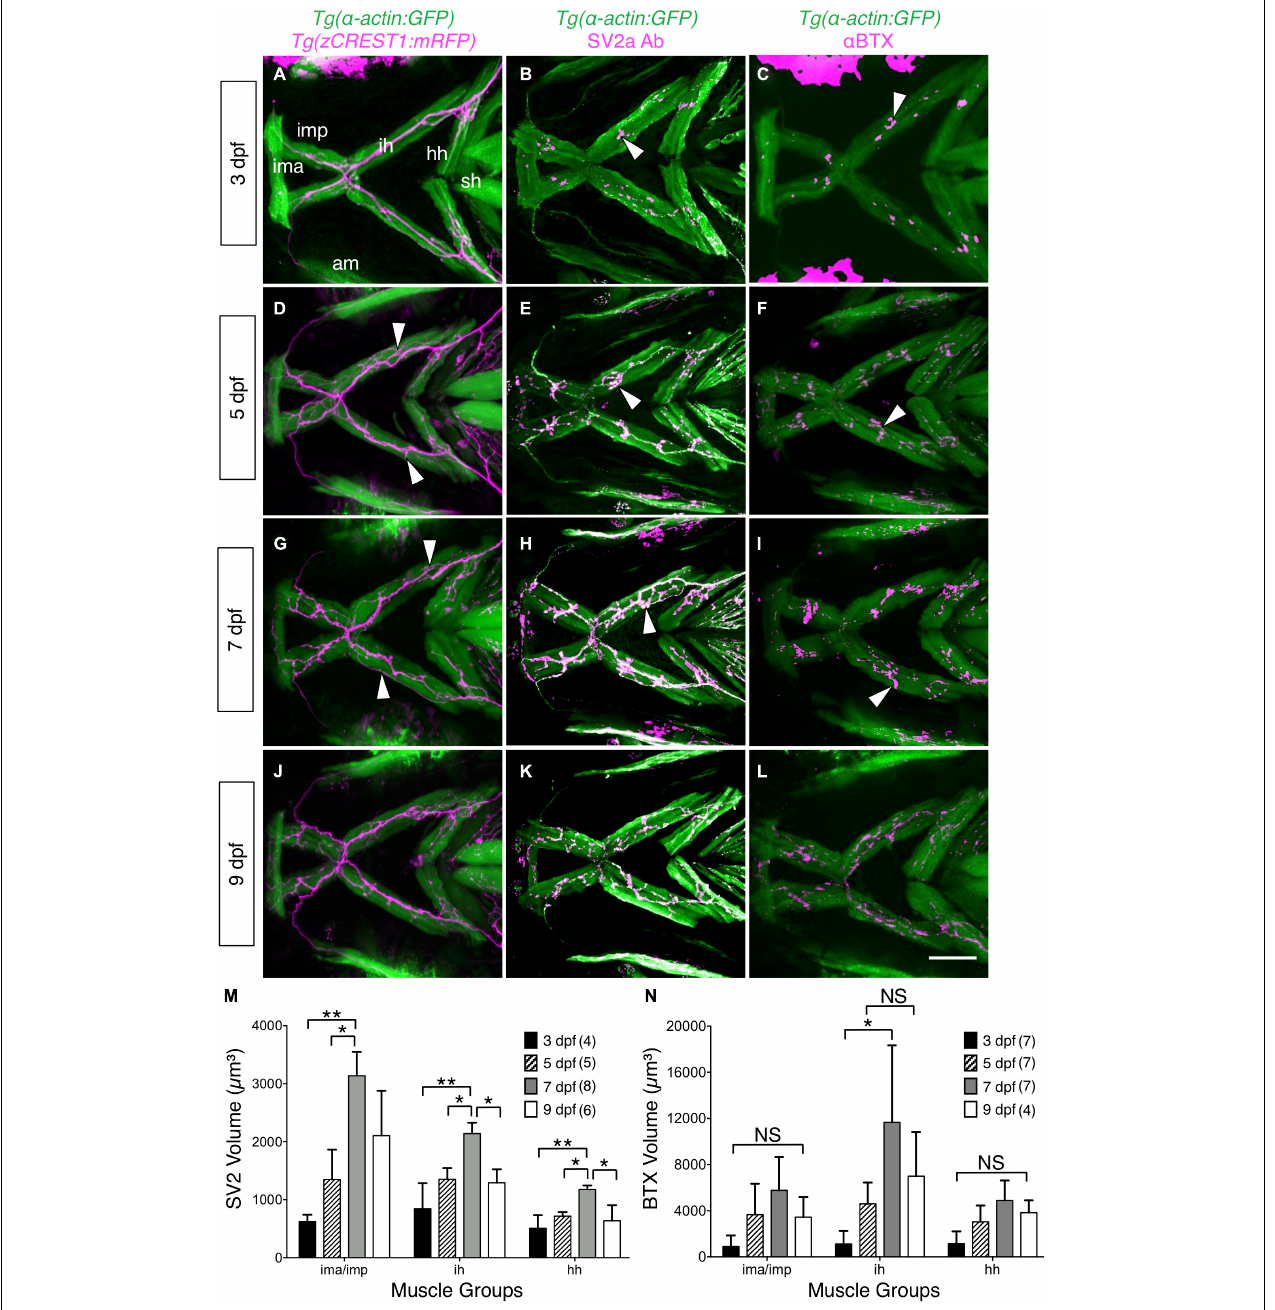
FIGURE 2 | Developmental changes in branchiomotor axon branching and synaptic structures at the jaw neuromuscular junctions. Ventral views with anterior to the left of the jaw musculature. (A,D,G,J) Axon (magenta) outgrowth on jaw muscles (green) in 3, 5, 7, and 9 dpf Tg ( α -actin:GFP ); Tg ( zCREST1:mRFP ) larvae. 3D rendering of muscles and axons were overlaid to determine axon position relative to the muscles. Fine axon branches (white arrowheads) across the jaw muscles increased as larvae aged. (B,E,H,K) SV2a antibody (magenta) labeled presynaptic structures on the jaw muscles (green) in 3, 5, 7, and 9 dpf Tg ( isl1:GFP ) ; Tg ( α -actin:GFP ) larvae. 3D rendering was used to visualize the presynaptic regions in contact with the muscles (arrowheads), and calculate their volumes. (M) Presynaptic volumes increased greatly from 3 to 7 dpf larvae, especially for ima/imp and ih muscles. There was a significant increase from 5 to 7 dpf in the ima/imp, ih, and hh muscles. Both ih and hh muscles had a significant decrease in presynaptic volume from 7 to 9 dpf larvae. (C,F,I,L) Ventral view with anterior to the left. Acetylcholine receptor (AChR) clusters (arrowheads) were labeled with alpha-bungarotoxin ( α BTX) (magenta) on the jaw muscles (green) in live 3, 5, 7,